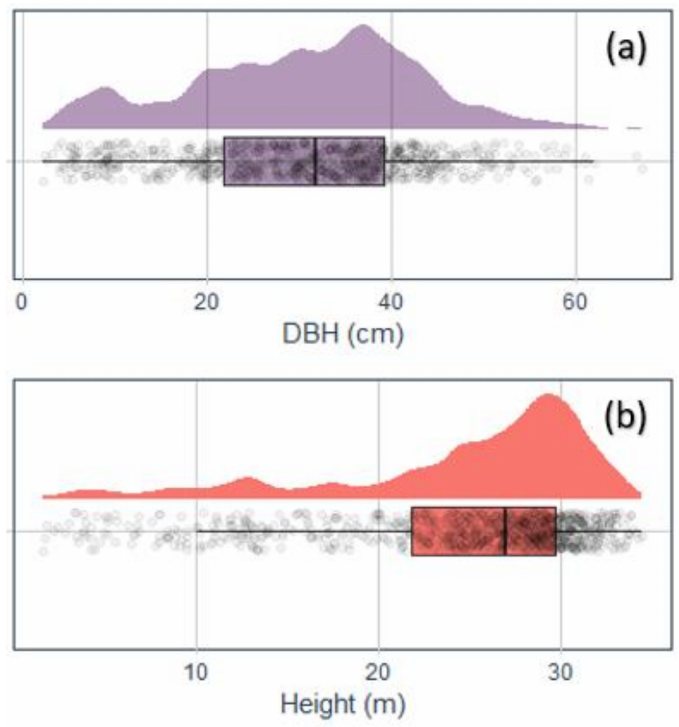
Figure 2. Plots showing the distribution of diameter ( a ) and height ( b